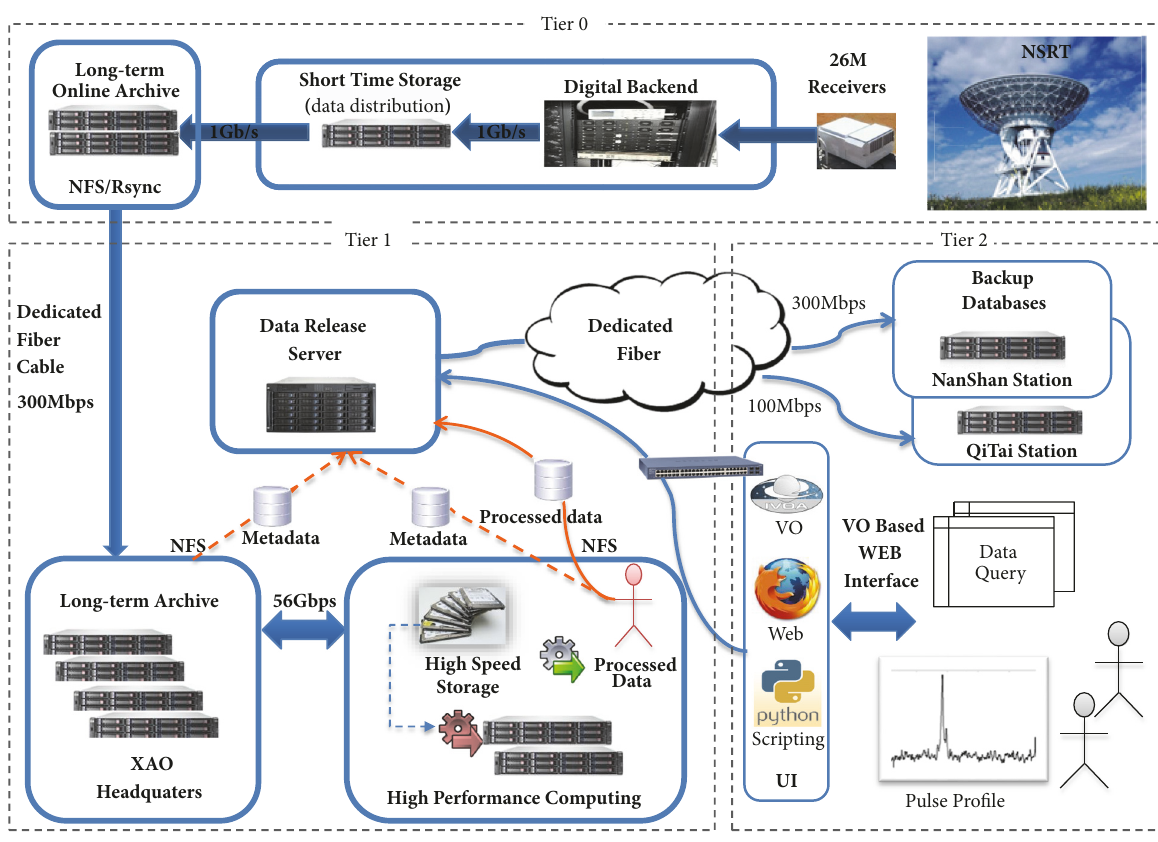
Figure 1: Overall design of NSRT pulsar data management